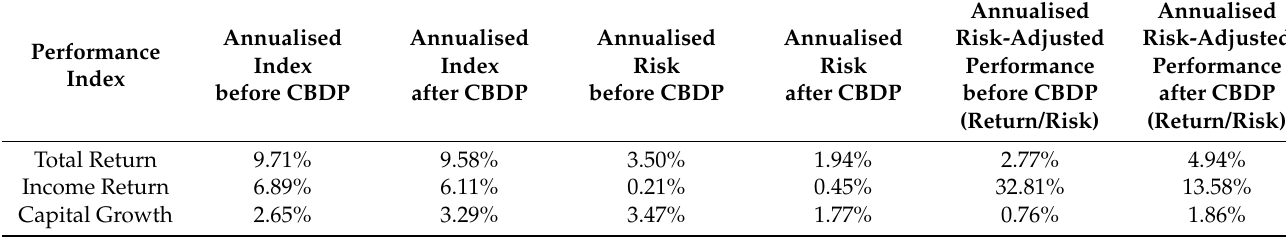
Table 2. Aggregate performance